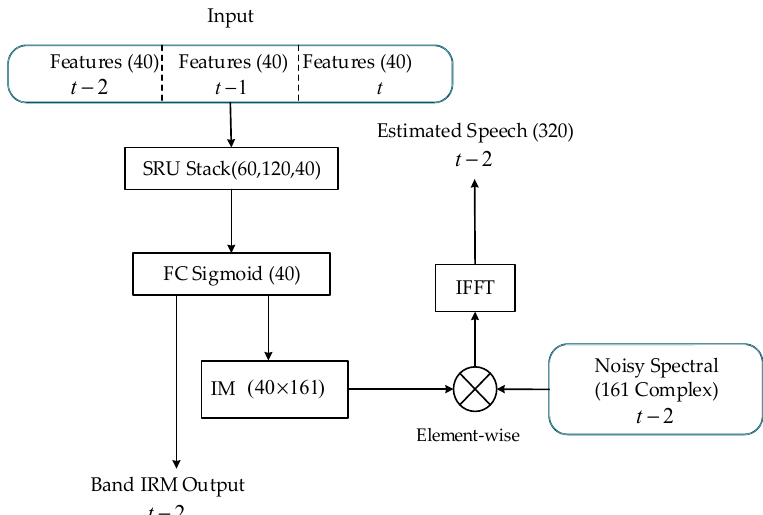
Figure 6. The diagram of the proposed Mel-scale sub-band simple recurrent unit (SRU)-based neural network. FC means the fully connection. IM indicates interpolate matrix. IFFT means Inverse fast Fourier transform and IRM is ideal ratio mask.